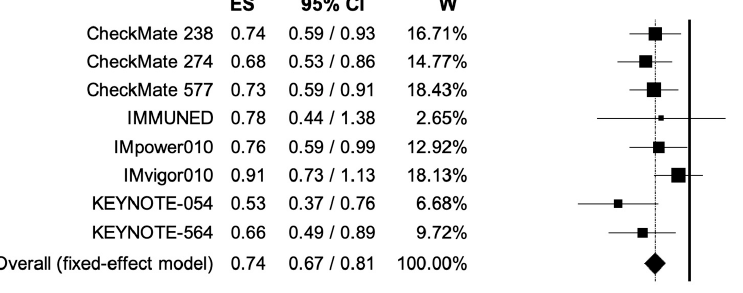
Figure 4. Forest plot of comparison between adjuvant PD-1 and PD-L1 inhibitors versus control (placebo/ipilimumab/observation/best supportive care) in cancer patients; the outcome of interest was relapse-free survival (RFS) in male patients. Abbreviations: CI: confidence interval; ES: effect size; and W: weight.